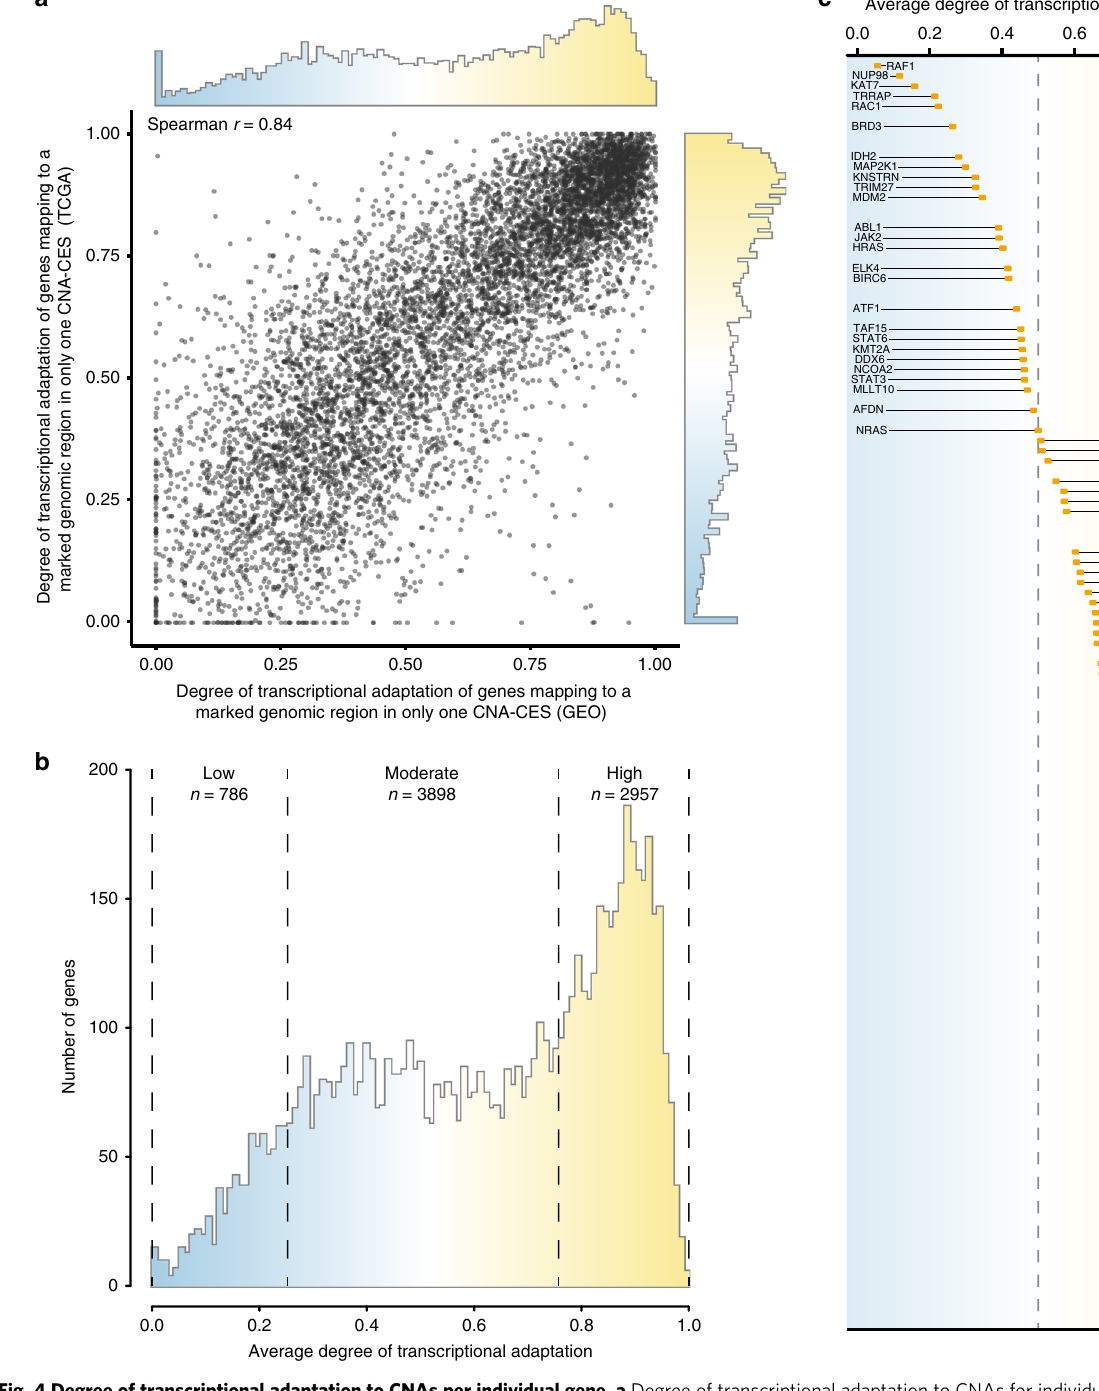
Fig. 4 Degree of transcriptional adaptation to CNAs per individual gene. a Degree of transcriptional adaptation to CNAs for individual genes mapping to a marked genomic region in a single CNA-CES in both the GEO and TCGA dataset ( n = 7641). b Distribution of the average degree of transcriptional adaptation to CNAs for genes mapping to a marked genomic region in a single CNA-CES in both the GEO and TCGA dataset. c Average degree of transcriptional adaptation to CNA for a set of oncogenes obtained from the Catalogue of Somatic Mutations in Cancer Gene